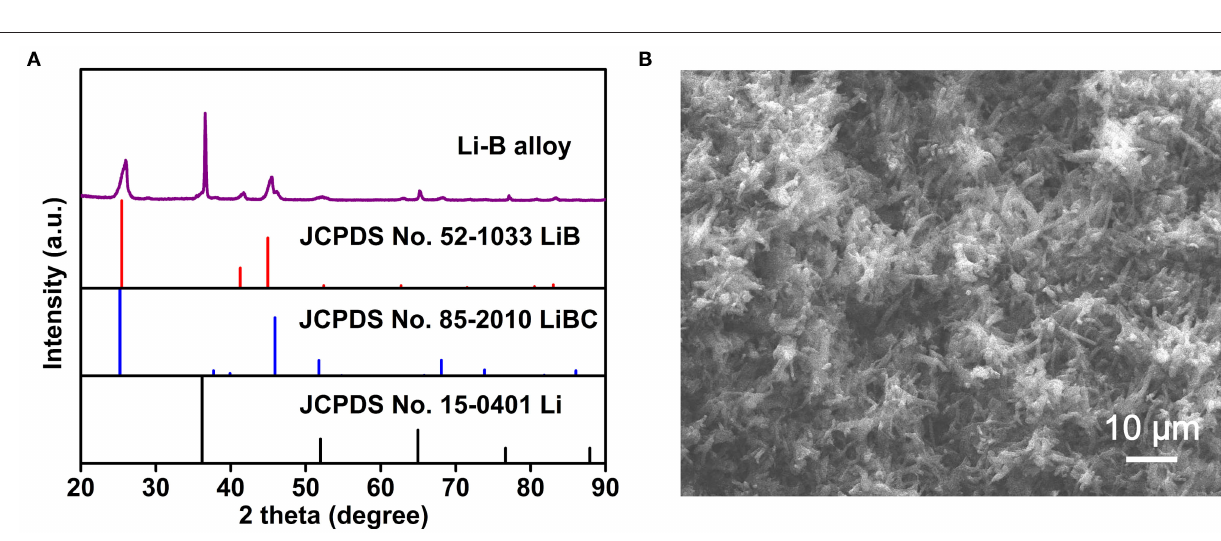
1 mm, and the spacing between slices was 0.5